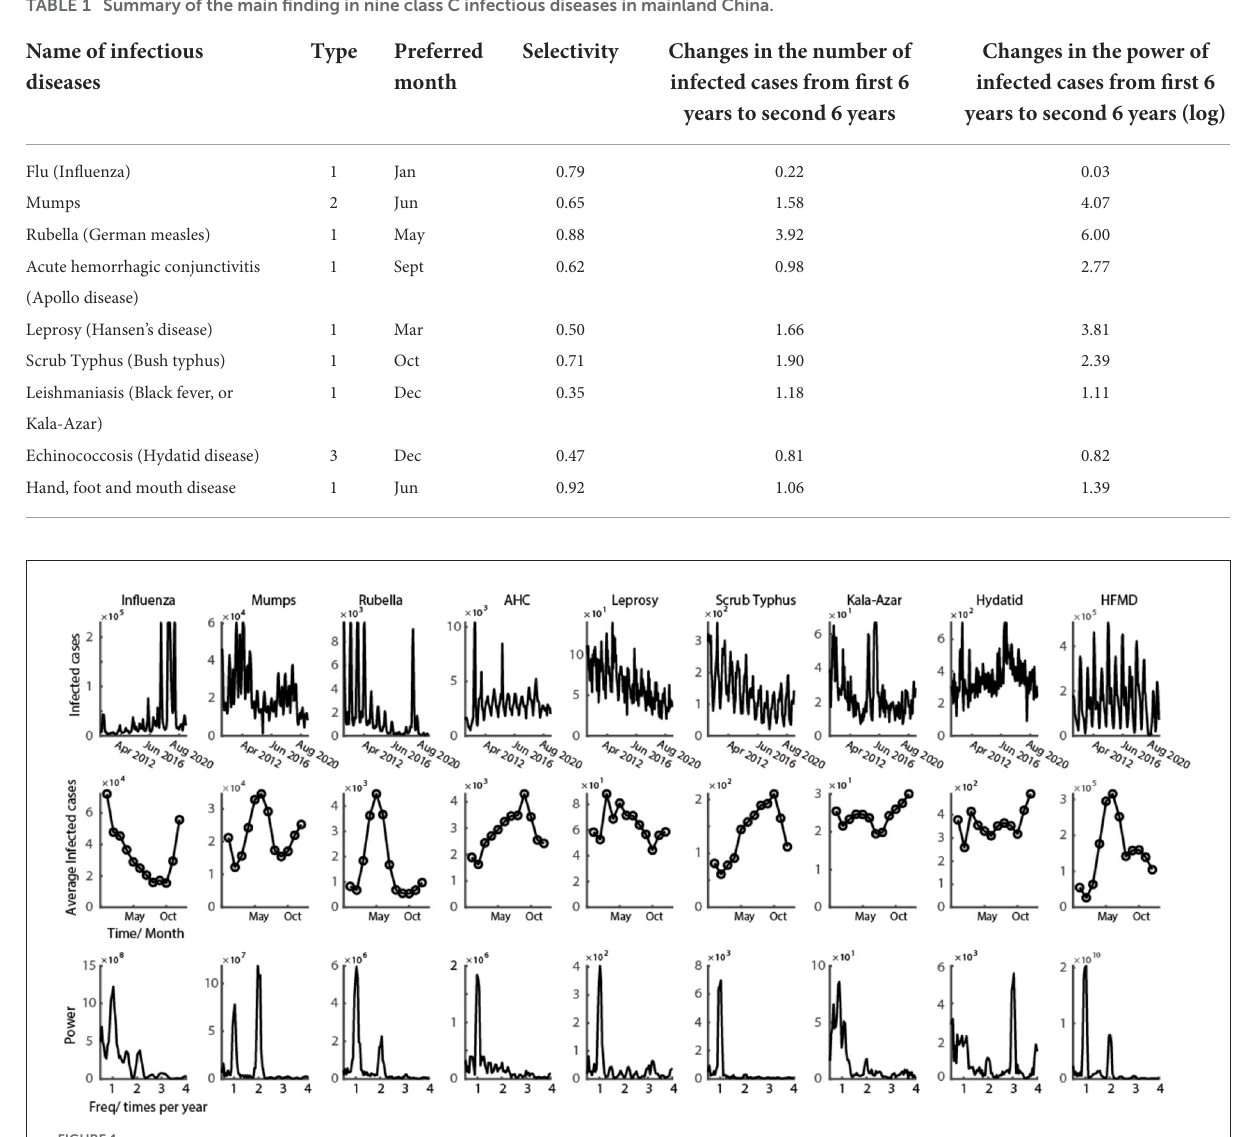
TABLE 1 Summary of the main finding in nine class C infectious diseases in mainland China.